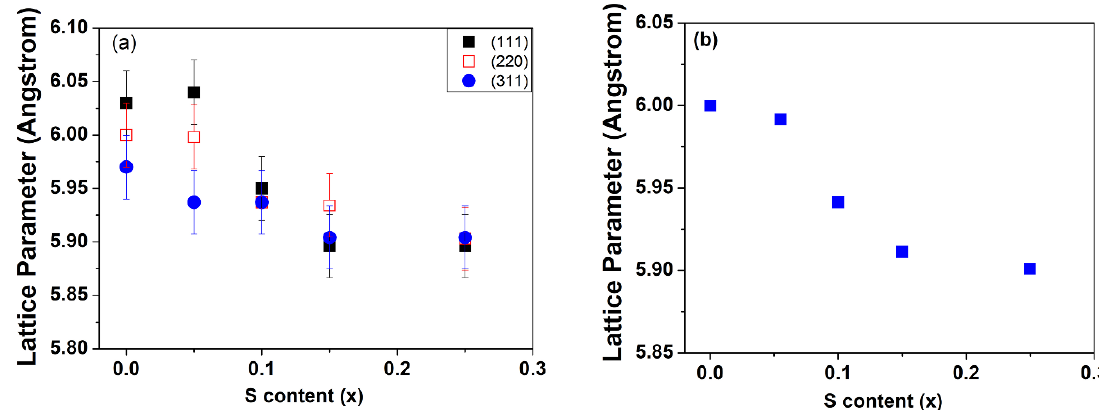
Figure 3. ( a ) Lattice parameters calculated based on a position of different planes. ( b ) The mean lattice parameters calculated based on a position of different planes using ANOVA methods.